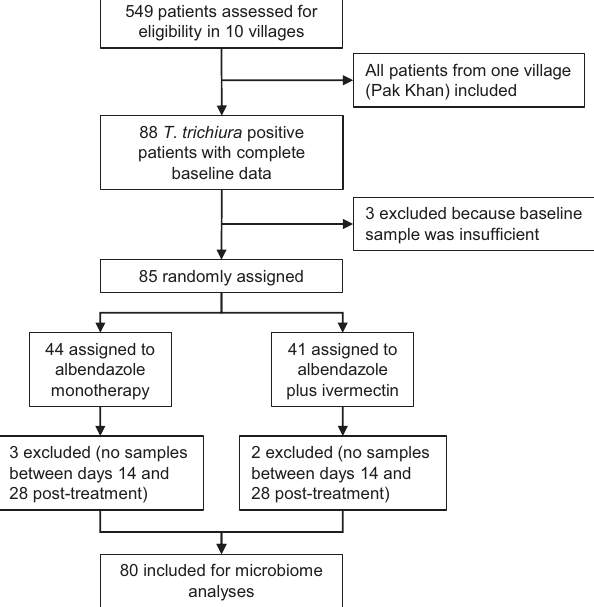
Fig. 1 Trial pro fi le. Trial pro fi le depicting the number of patients included for microbiome